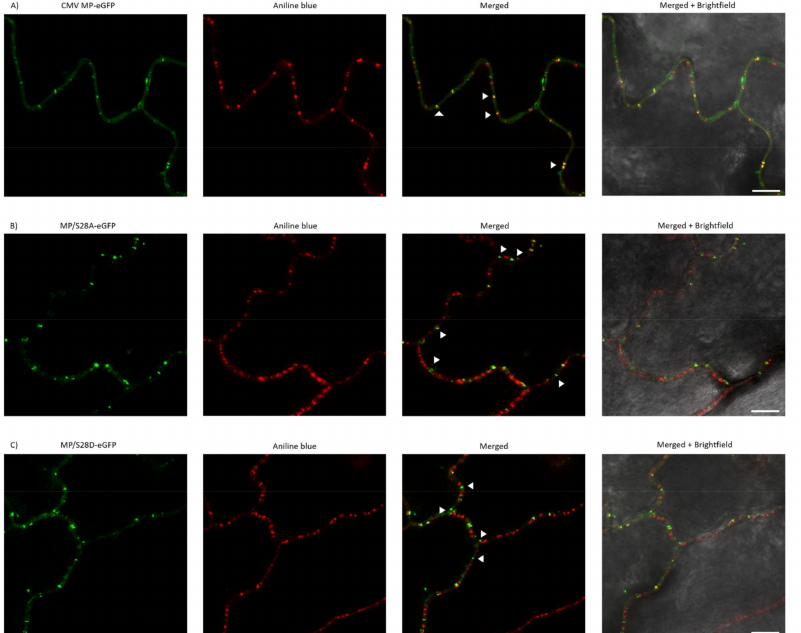
Figure 5. Subcellular localization of wild type and mutant MP-eGFP constructs in Nicotiana tabacum cv. Xanthi leaves. ( A – C ) Aniline blue staining served as a plasmodesmata marker. Images were taken 24–48 h after agroinfiltration with a confocal microscope. For better visualization, eGFP fluorescent and aniline blue images were false colored as green and red, respectively. Arrowheads indicate the punctate structures. Scale bar: 10 µ m.